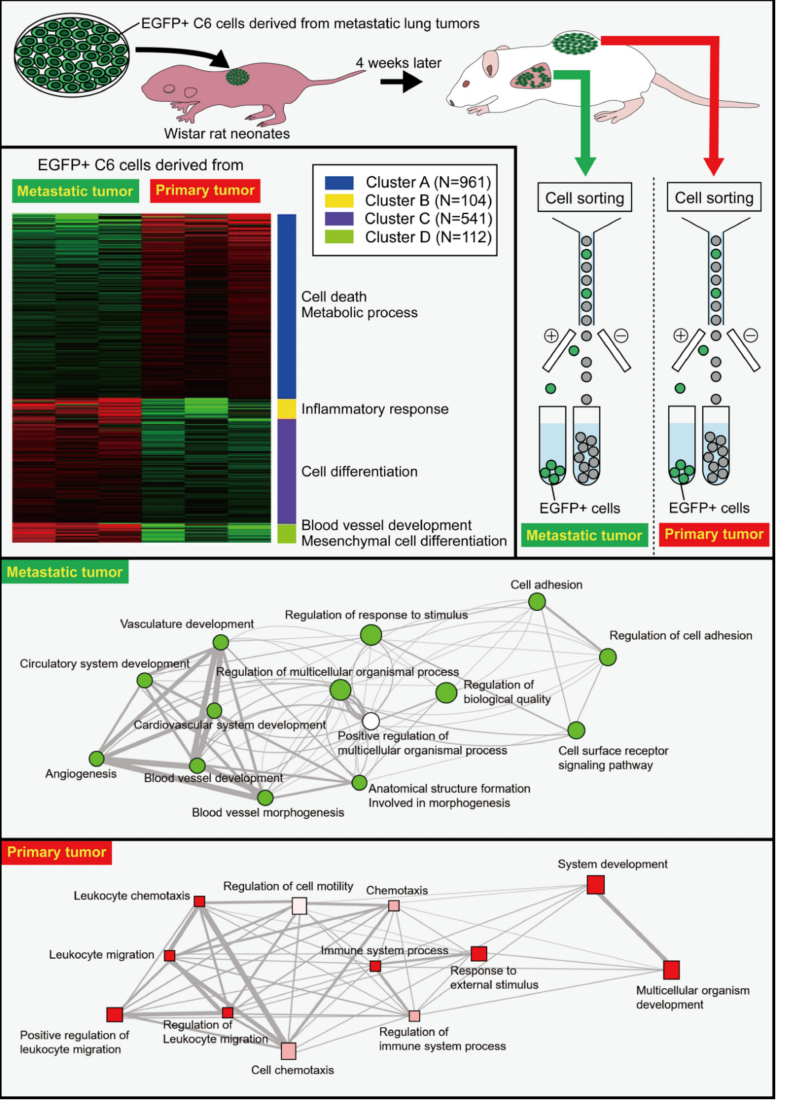
Figure 1. Differential gene expression in cells derived from metastatic and primary tumors as revealed by RNA-Seq. EGFP-expressing C6 glioma cells were transplanted in the back of Wistar rat